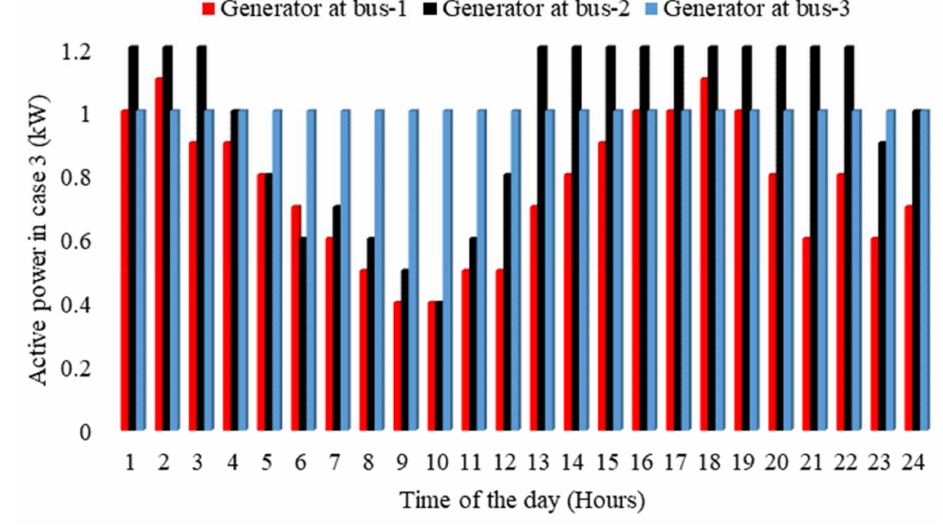
Figure 6. Generator commitment at Buses 1,2 and 3 (BESS case problem).